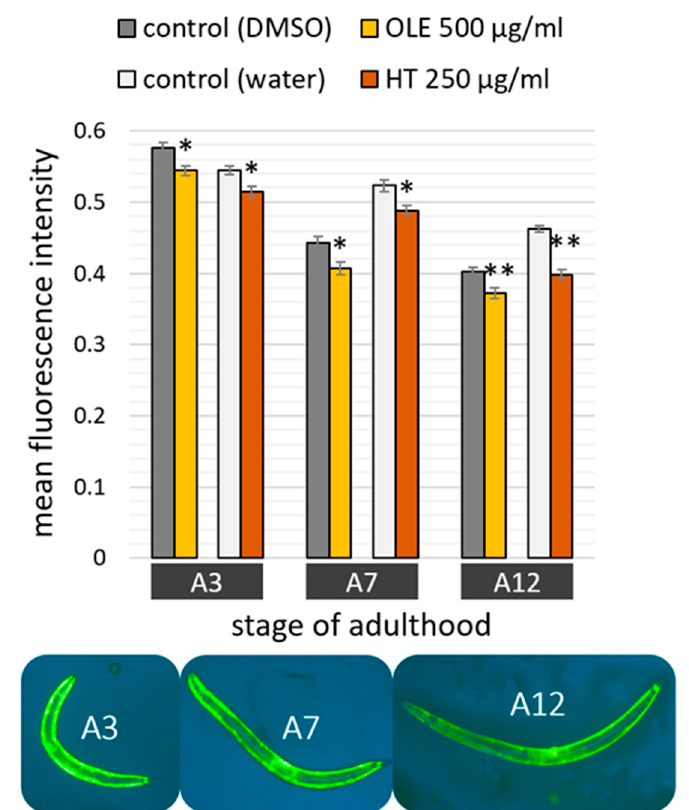
Figure 9. Changed α -synuclein accumulation in muscle cells of the OW13 strain after OLE and HT treatment. Nematodes from the OW13 strain were subjected to polyphenolic treatments starting from L4 and analysed by fluorescence microscopy using a yellow filter at day 3, 7, and 12 of adulthood. The bars represent the mean fluorescent intensity ± SEM from two biological repeats and the number of tested nematodes were: DMSO control ( n A3 = 32, n A7 = 48, n A12 = 38), OLE ( n A3 = 28; n A7 = 43, n A12 = 30), water control ( n A3 = 47, n A7 = 75, n A12 = 66) and HT ( n A3 = 35, n A7 = 39, n A12 = 44). A3, A7, A12: day 3, 7, 12 of adulthood. Di ff erences compared to control were considered significant at p < 0.05 (*) and p < 0.001 (**). In addition, three example pictures from untreated OW13 nematodes visualising the age-dependent fluorescent change are shown (all scale bars = 200 µ